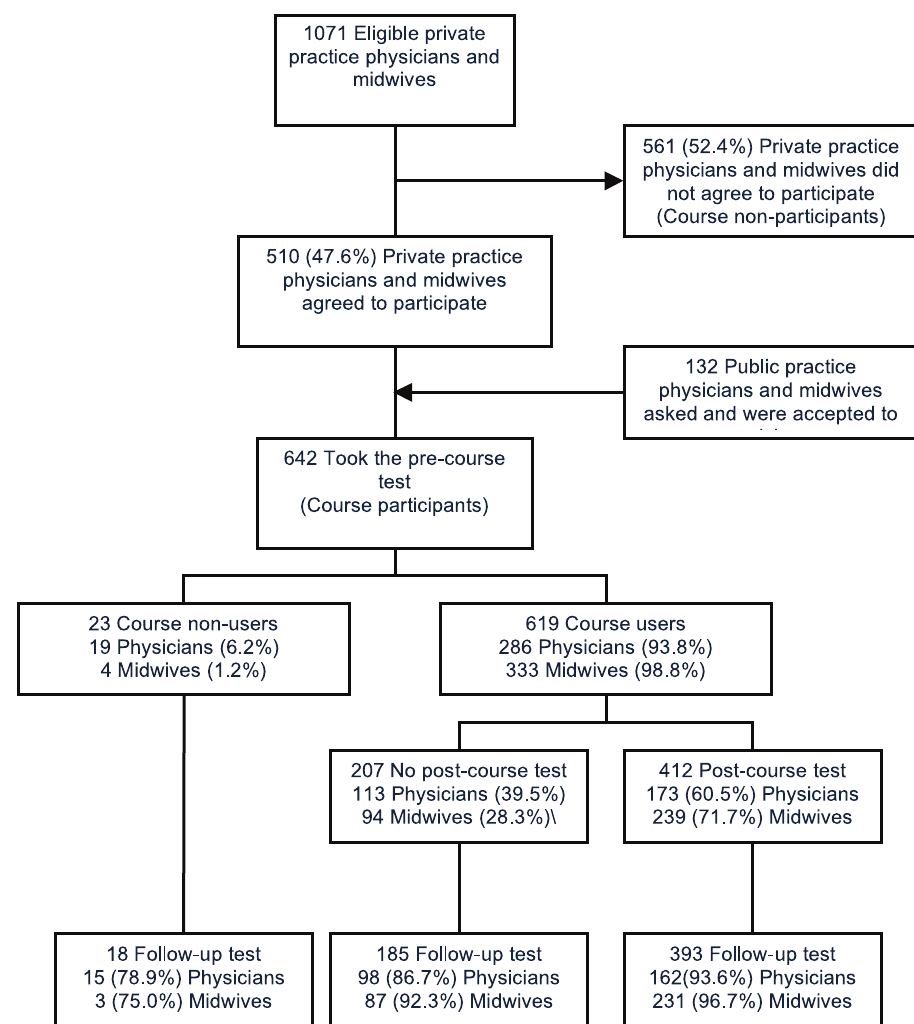
Figure 2. Participation flow of the Internet-based CE intervention.